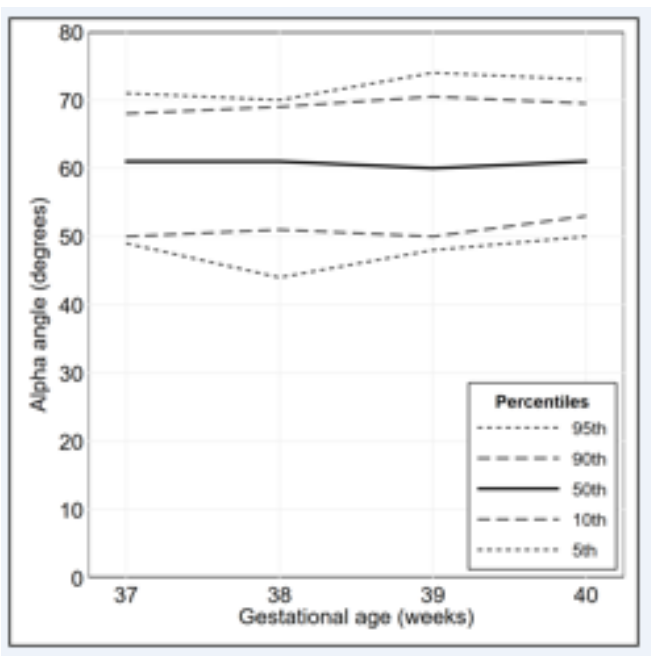
Figure 3. Beta-angle frequency polygon, overall and by gestational age (37 weeks: n = 131; 38 weeks: n = 101; 39 weeks: n = 100; 40 weeks: n = 100).